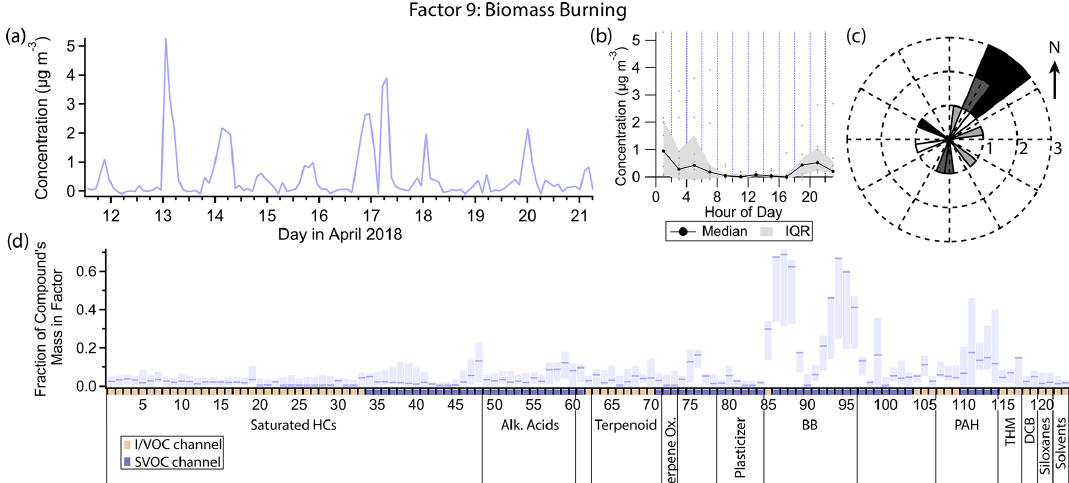
Figure 14. (a) Factor 9 timeline. (b) Diurnal profile for Factor 9. (c) Rose plot showing correlation of elevated emissions and wind direction. (d) Factor 9 composition profile. See Fig. 4 description for further information on how to read this figure.